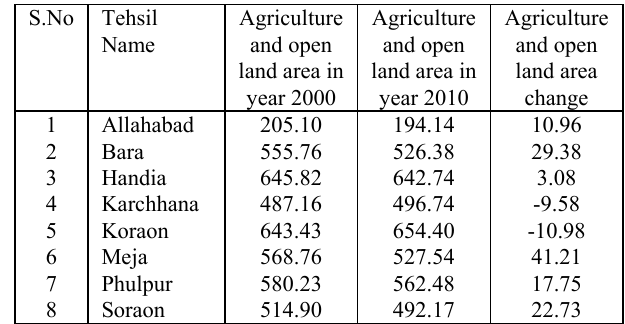
Figure 3, 4 and 5 are the maps of Allahabad district which are showing two LULC classes of the year 2000, 2010 and 2018 respectively.